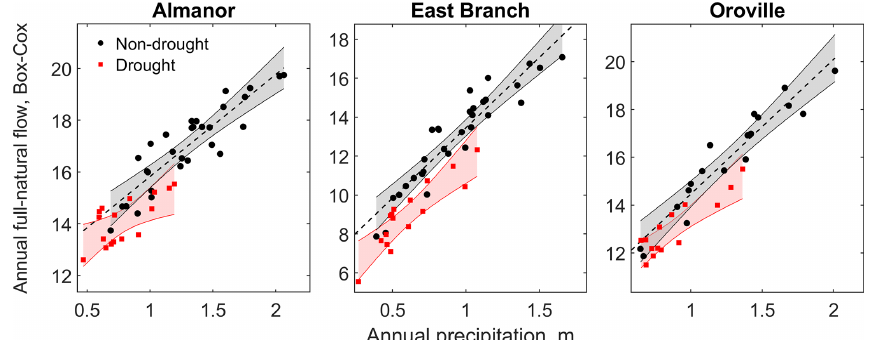
Figure 4. Precipitation–runoff relationship for drought (red) vs. non-drought (black) years and the three basins under study with complete annual runoff data (Almanor, East Branch, and Feather River at Oroville). The red and grey bands represent 95% confidence intervals for the regressions. The Box–Cox transformation for annual full-natural flow is introduced in Sect. 2.3.1, Eq.